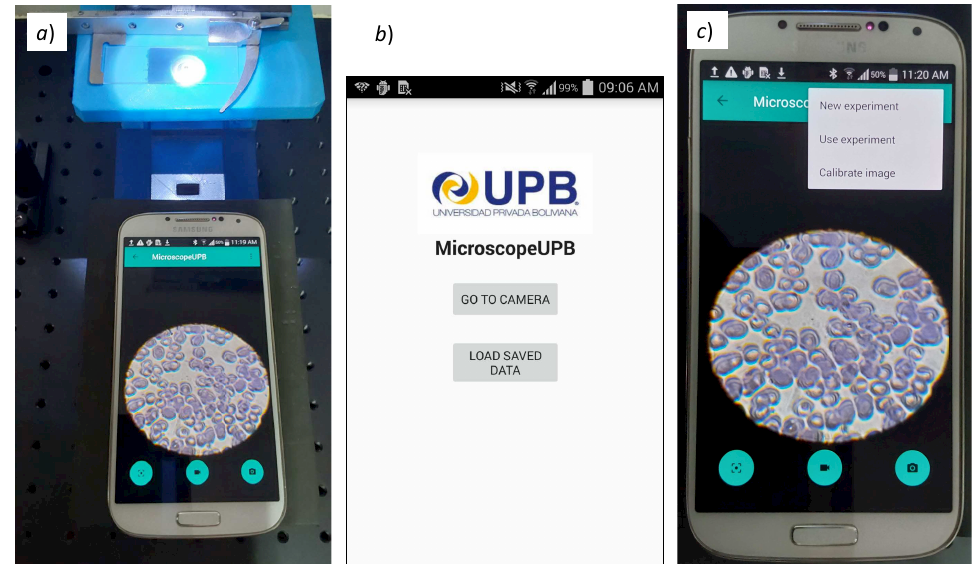
Figure 8. The Android app “MicroscopeUPB” for image capture and processing in operation. ( a ) Cal- ibration of positioning; ( b ) main screen of the app; ( c ) capture options for experiments.